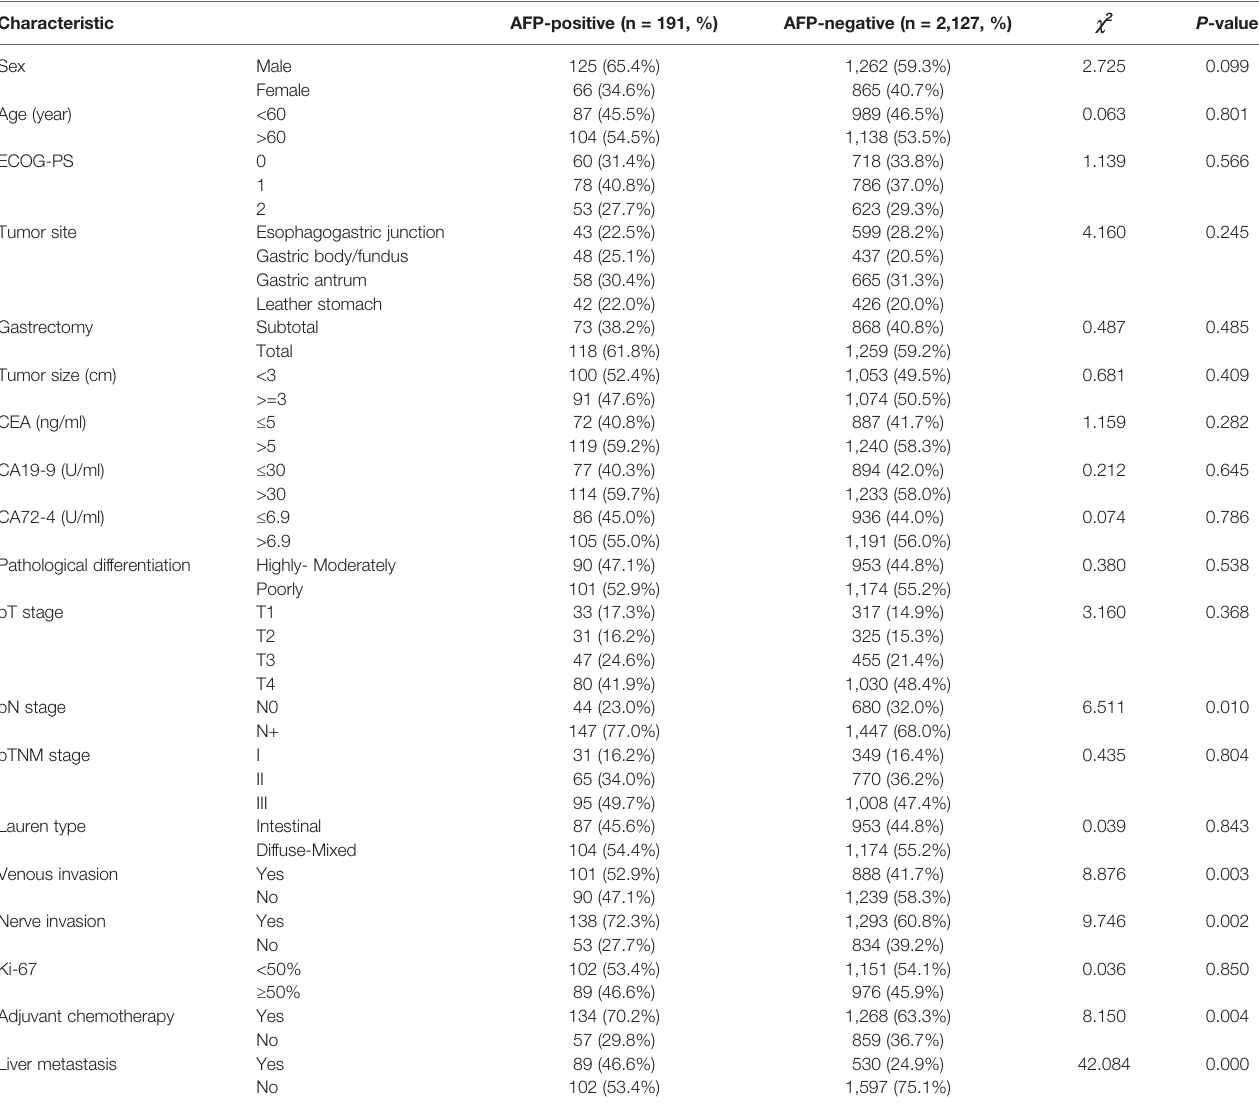
TABLE 1 | Comparison of clinicopathologic characteristics of patients with AFP-positive GC and AFP-negative GC.